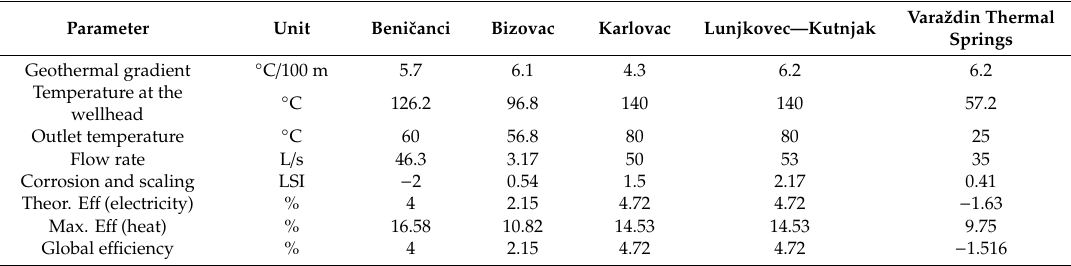
Table 6. Site calculated